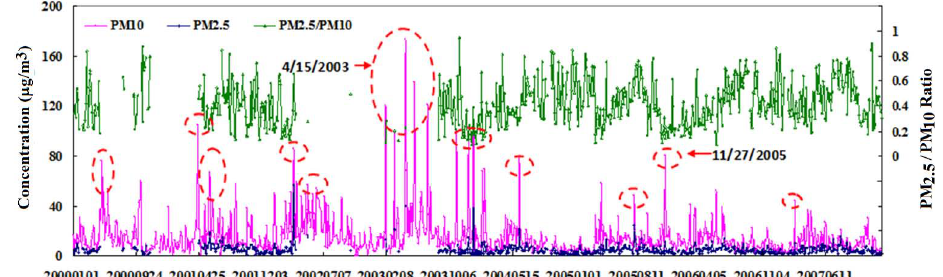
Fig. 5. Time series of PM 10 and PM 2 . 5 mass concentrations and their ratio at the Guadalupe Mountains National Park, TX (GUMO1) site between 2000 and 2007. Red circles indicate local dust events identified using the dust identification approach. The approach has effectively captured all satellite pinpointed dust events, including the 15 April 2003 storm and the 27 November 2005 storm.